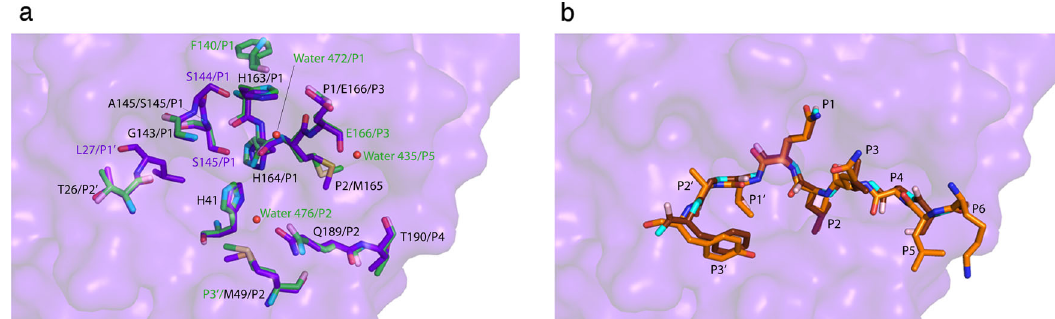
Fig.5|Comparisonof3CLprointeractionswithitsN-terminalsequenceandthe hNEMO 226 – 234 peptide. a The surface of chain B from our hNEMO 226 – 234 -bound structure is depicted as in Fig. 2c. This is juxtaposed with residues from our structure that form interactions with the hNEMO 226 – 234 peptide (purple sticks) as well as N-terminal interacting residues (green sticks) from a structure of 3CLpro boundtoanN-terminalpeptide(PDB_ID:7N89).For7N89,oxygensarecoloredlight red,nitrogensarecoloredaquamarineandsulfursarecoloredlightyellow,forease of comparison. Residues forming conserved interactions are labeled in black. Those found only in hNEMO 226 – 234 -bound 3CLpro are labeled in purple.